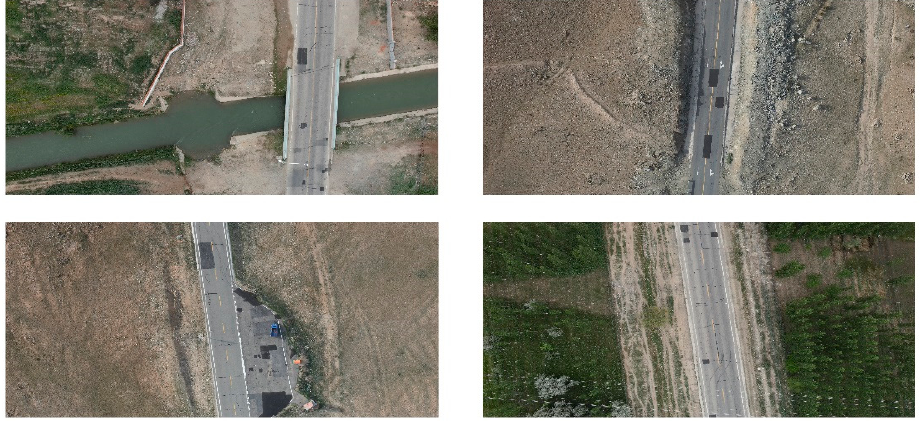
Figure 9. Sample refill